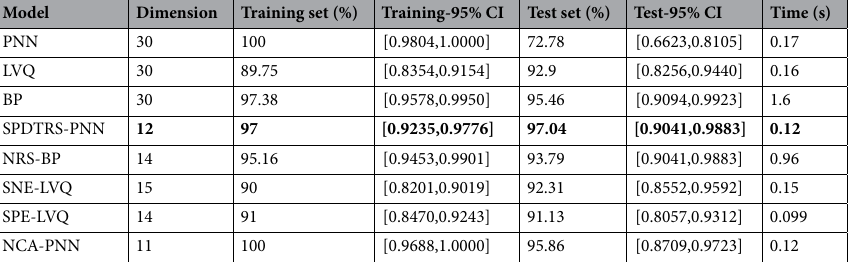
Table 3. Comparison of different models. The bold font in the table is the parameter value with better effect selected from each model.